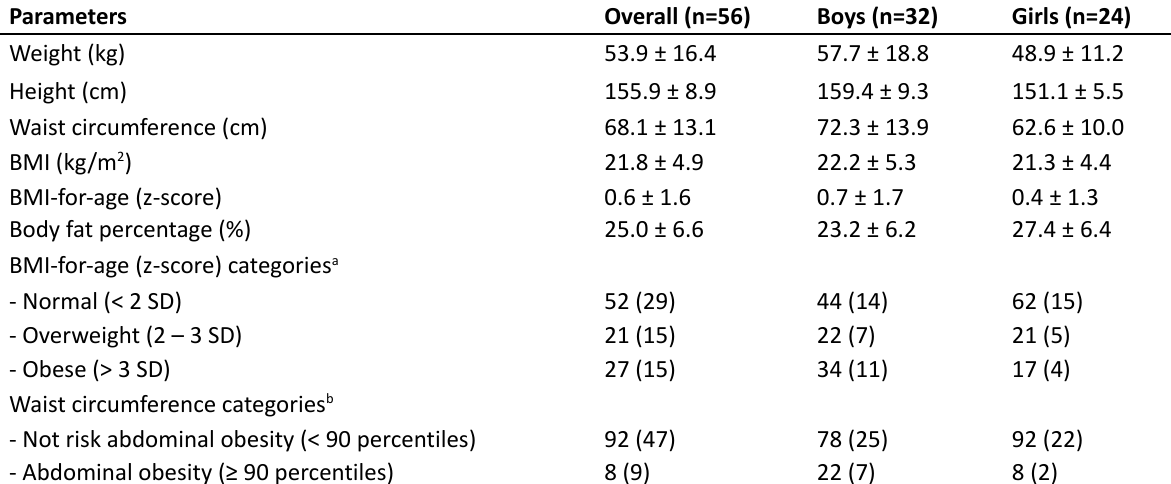
Table 1. Subject’s anthropometric and Body Composition [Mean ± SD/ % (n)]